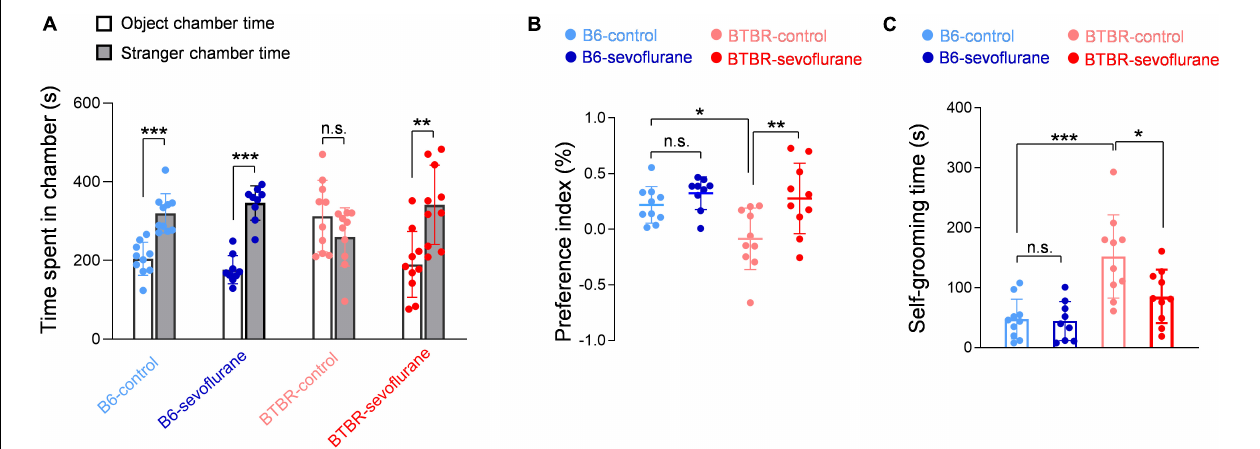
FIGURE 4 | Autistic behavior in BTBR mice is reduced by early sevoflurane exposures in BTBR mice. (A,B) Sociability was evaluated using the three-chamber test by measuring the time spent in each side chamber. (A) Quantification of the time spent in each side chamber (B6-control, n = 10 mice; B6-sevoflurane, n = 9 mice; BTBR-control, n = 10 mice; BTBR-sevoflurane, n = 10 mice). (B) Quantification of the preference index (B6-control, n = 10 mice; B6-sevoflurane, n = 9 mice; BTBR-control, n = 10 mice; BTBR-sevoflurane, n = 10 mice). (C) Repetitive behavior was evaluated by measuring the duration of self-grooming behavior. (B6-control, n = 10 mice; B6-sevoflurane, n = 9 mice; BTBR-control, n = 10 mice; BTBR-sevoflurane, n = 10 mice). Values are presented as means ± SD (* p < 0.05, ** p < 0.01, *** p < 0.001, n.s., not